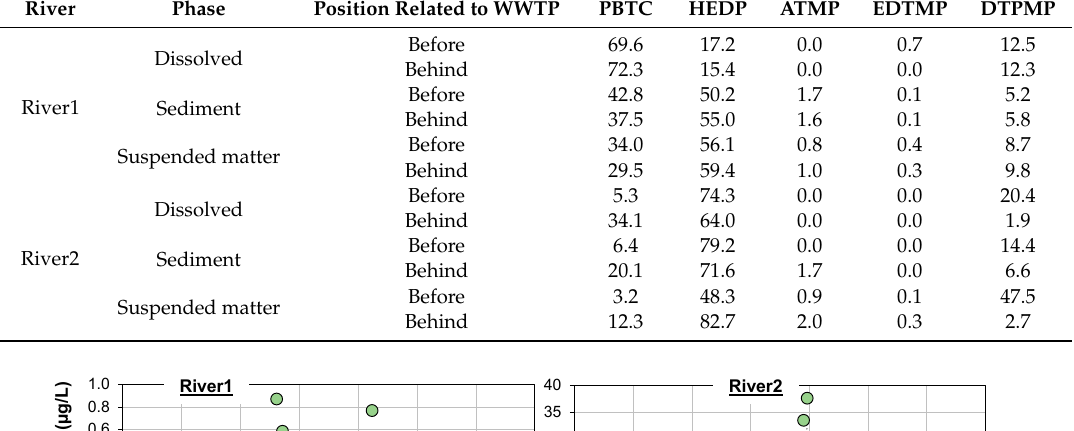
Figure 3. Boxplots (minimum, first quartile, median, third quartile, and maximum) of the concentrations of dissolved phosphonates ( top ) and phosphonate loads of sediments ( bottom ) in the two investigated rivers before ( left boxplot ) and behind the WWDs ( right boxplot ). LOQ: limit of quantification.